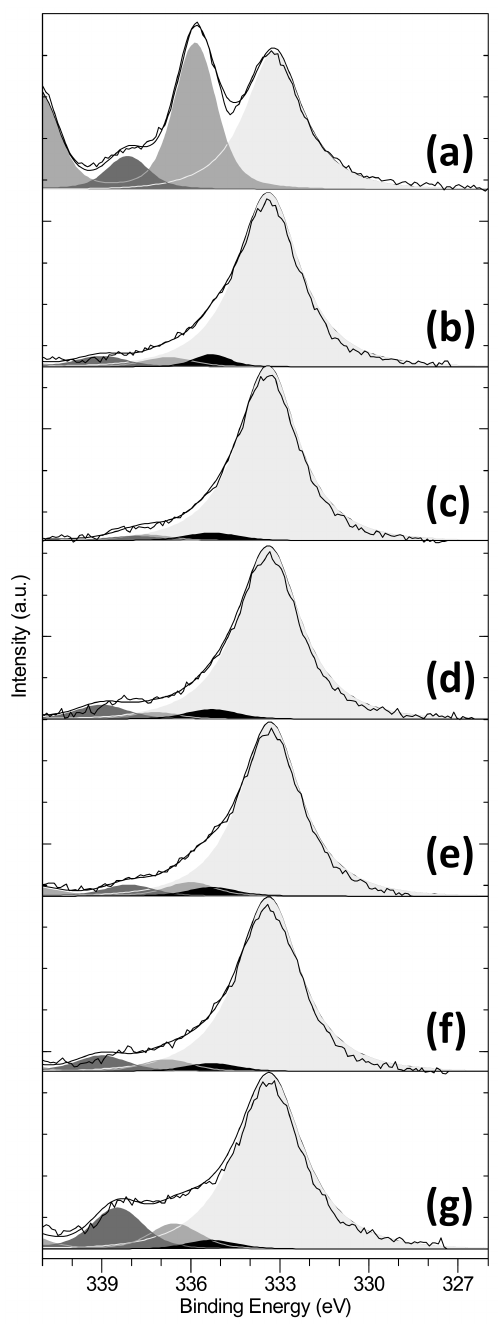
Figure 3. XPS high resolution spectra for samples listed in Table 3, corresponding to Zr 3p3/2 (light gray), Pd 3d5/2 (medium and dark gray corresponding to Pd 0 and Pd δ + , respectively), and Au 4d5/2 (black): ( a ) 0.82%PdCZ; ( b ) 4.3AuPd-O; ( c ) 3.7AuPd-O; ( d ) 1.8AuPd-O; ( e ) 1.4AuPd-O; ( f ) 0.6AuPd-O; and ( g )